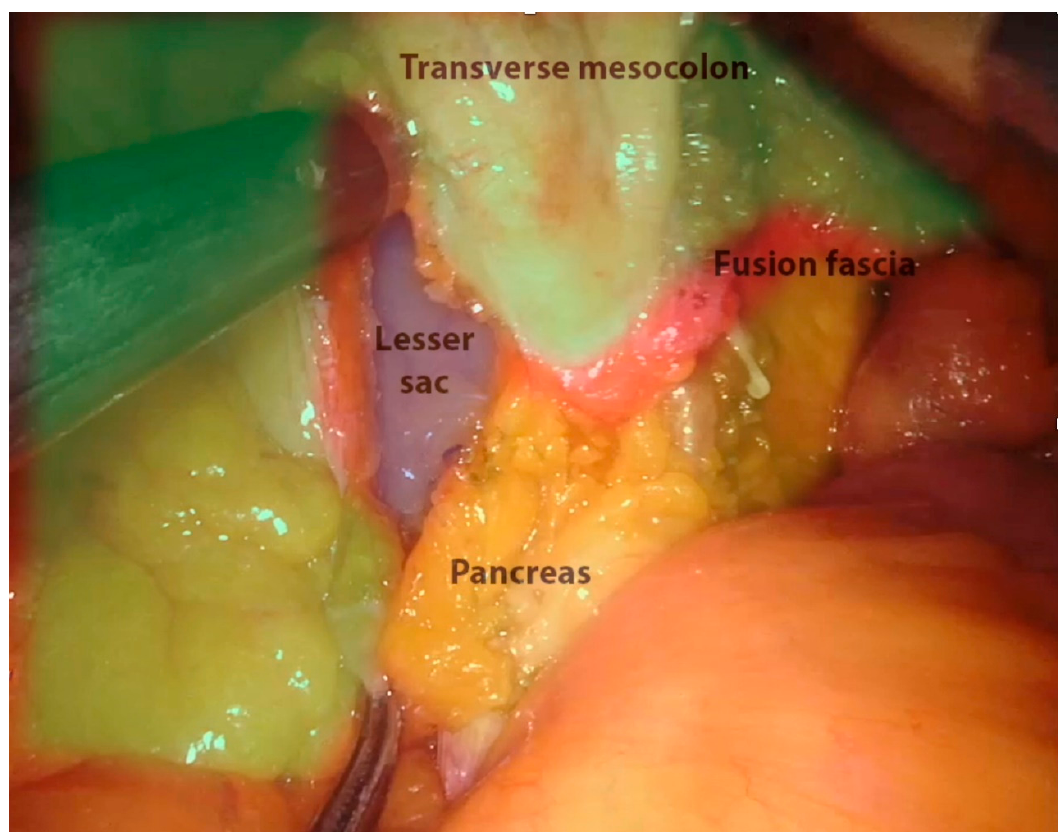
Figure 5. Splenic flexure takedown— bottom to up approach.